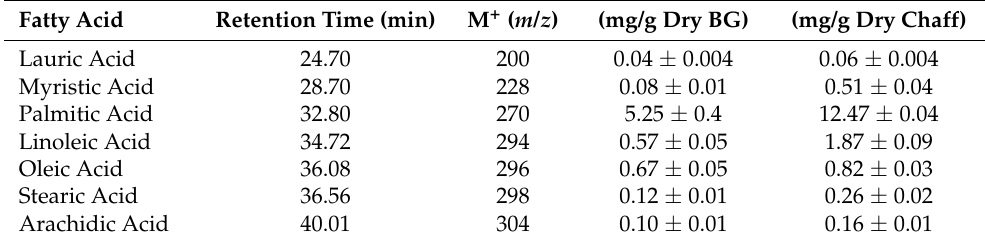
Table 2. Fatty acid methyl ester analysis of bluegrass (BG) and chaff CH 2 Cl 2